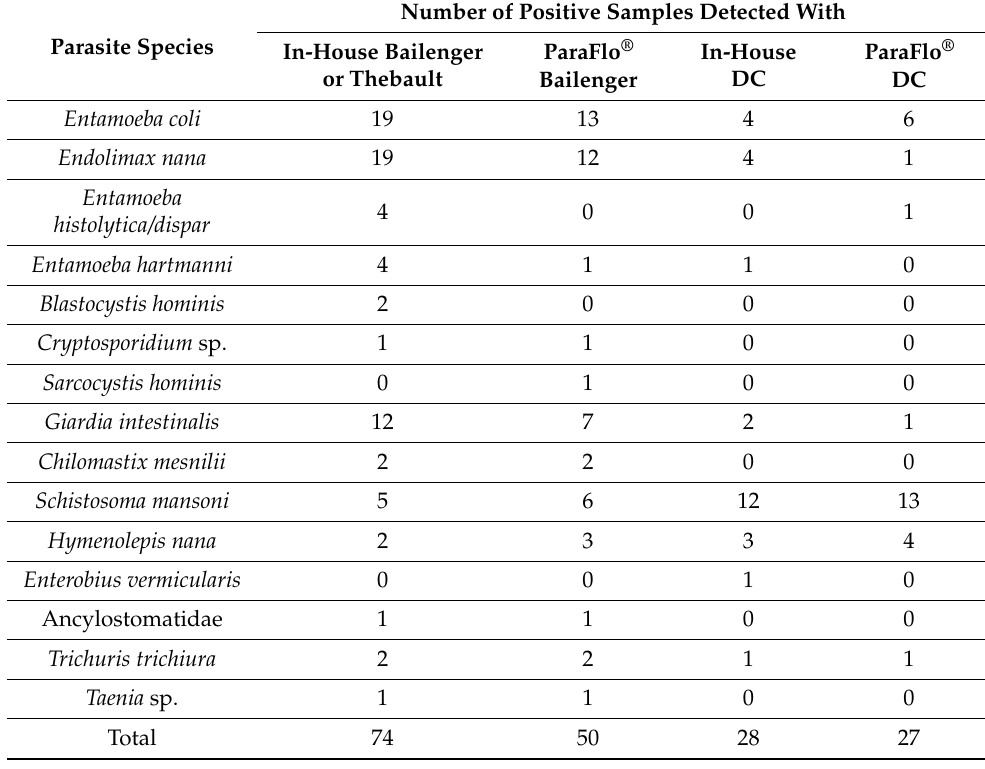
Table 1. Parasite species detected using the in-house and concentration methods (n = 93 samples). Number of Positive Samples Detected With Parasite Species In-House Bailenger In-House ParaFlo ® ParaFlo ® or Thebault DC Bailenger DC Entamoeba coli 19 Endolimax nana Entamoeba histolytica/dispar Entamoeba hartmanni